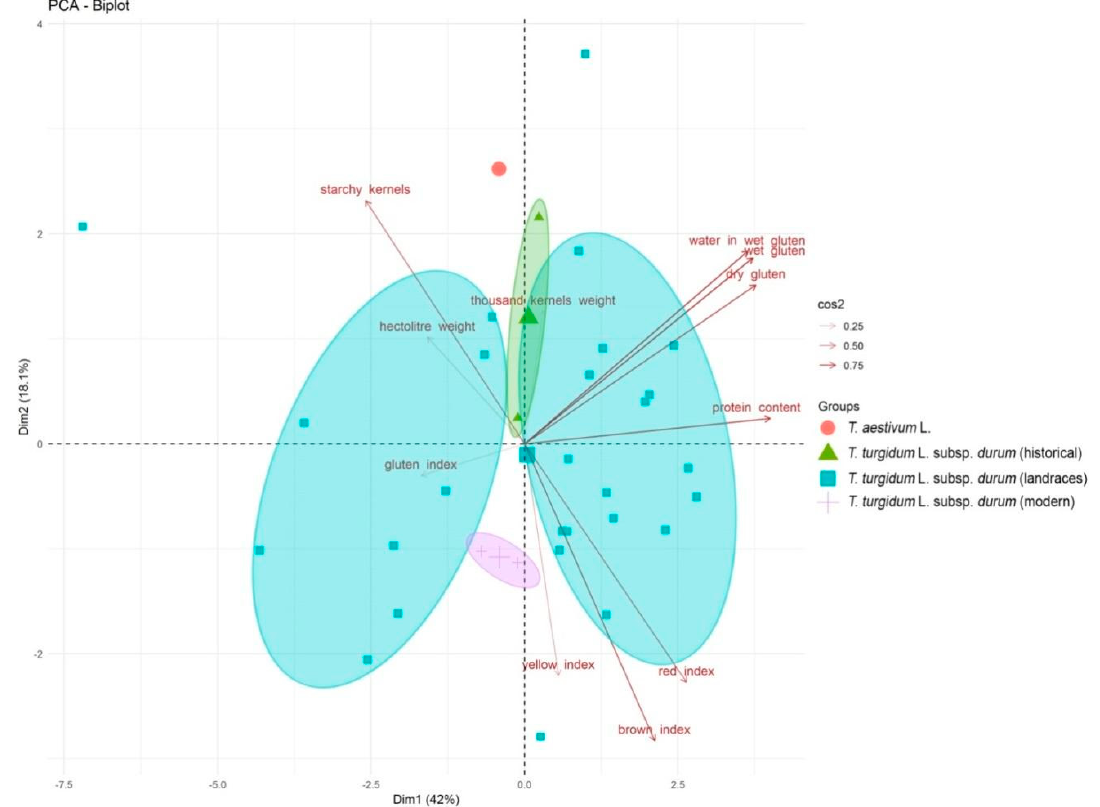
Figure 2. Principal Component Analysis (PCA) of the quality-related traits. Based on their origin, samples were organized in four main groups: (1) T. aestivum L., (2) T. turgidum L. subsp. durum historical varieties (Cappelli and Trinakria), (3) T. turgidum L. subsp. durum ancient landraces (27), and (4) T. turgidum L. subsp. durum modern varieties (Claudio and Simeto). Traits associated with the samples discrimination are indicated in the plot, underlining their significance values (0.25 < cos2 < 0.75). The medians for each group were also visualized.